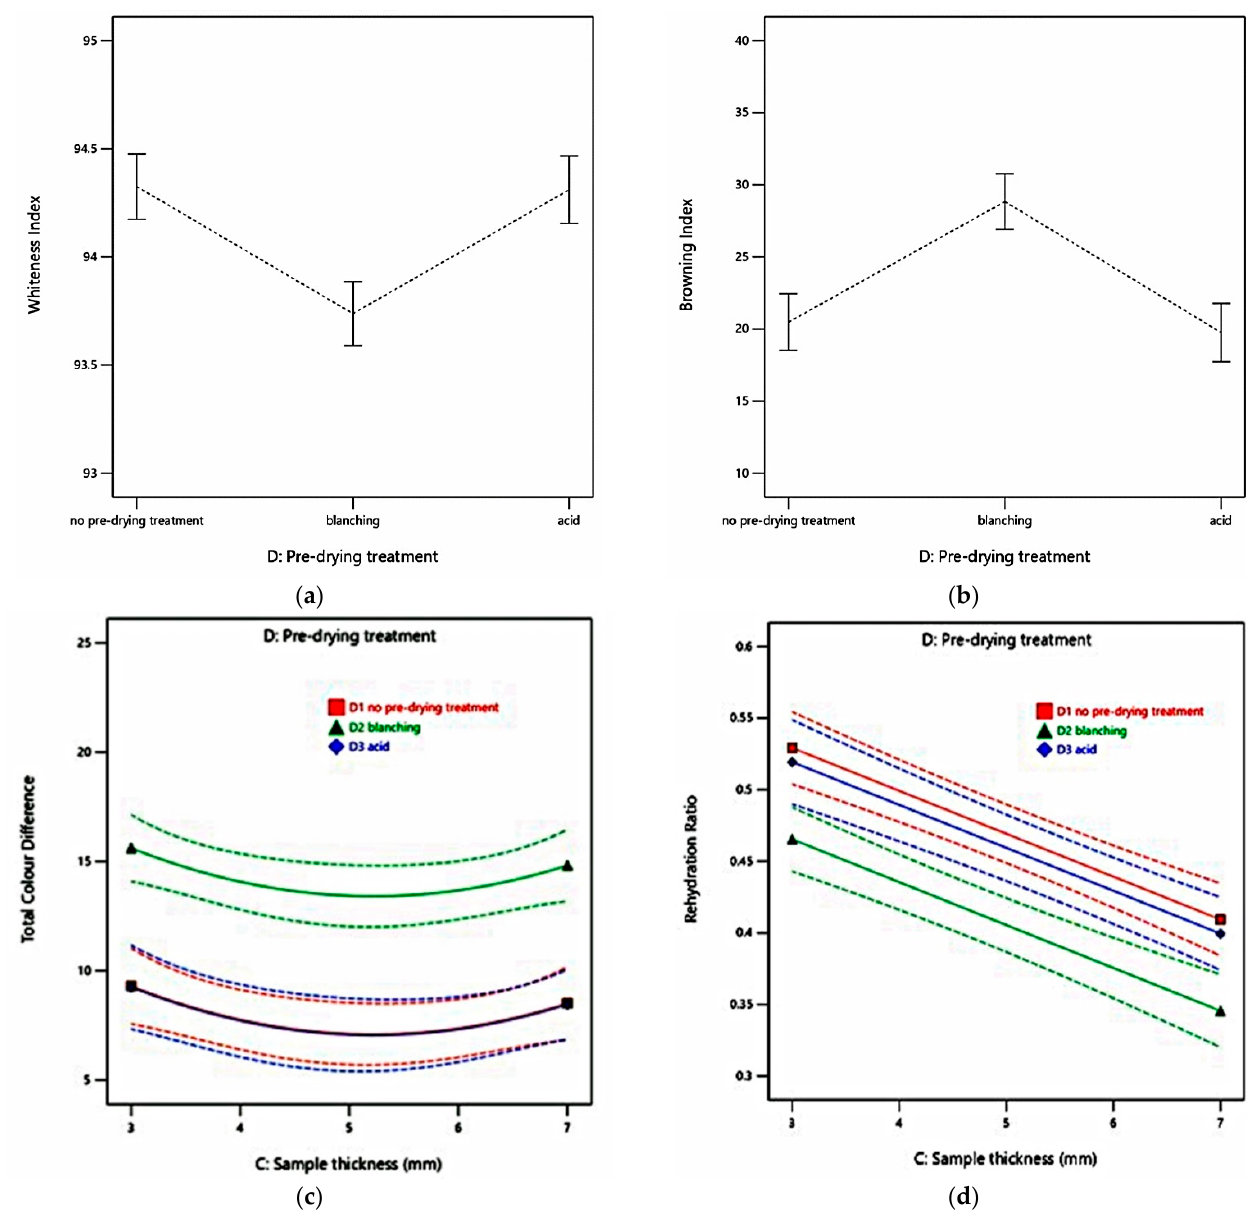
Figure 4. Physical properties as a function of factors: ( a ) WI of celeriac slices at different pre-drying treatments; ( b ) BI of celeriac slices at different pre-drying treatments; ( c ) Δ E * ab of celeriac slices at different pre-drying treatments and sample thicknesses; ( d ) RR of celeriac slices at different sample thicknesses and pre-drying treatments.